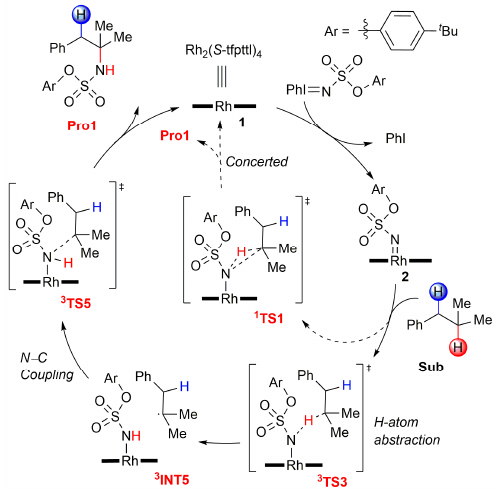
Figure 2. Proposed reaction mechanisms for Rh 2 ( S -tfpttl) 4 -catalyzed intermolecular amination of tertiary C–H bonds. Ar = p - tert -butylphenyl.